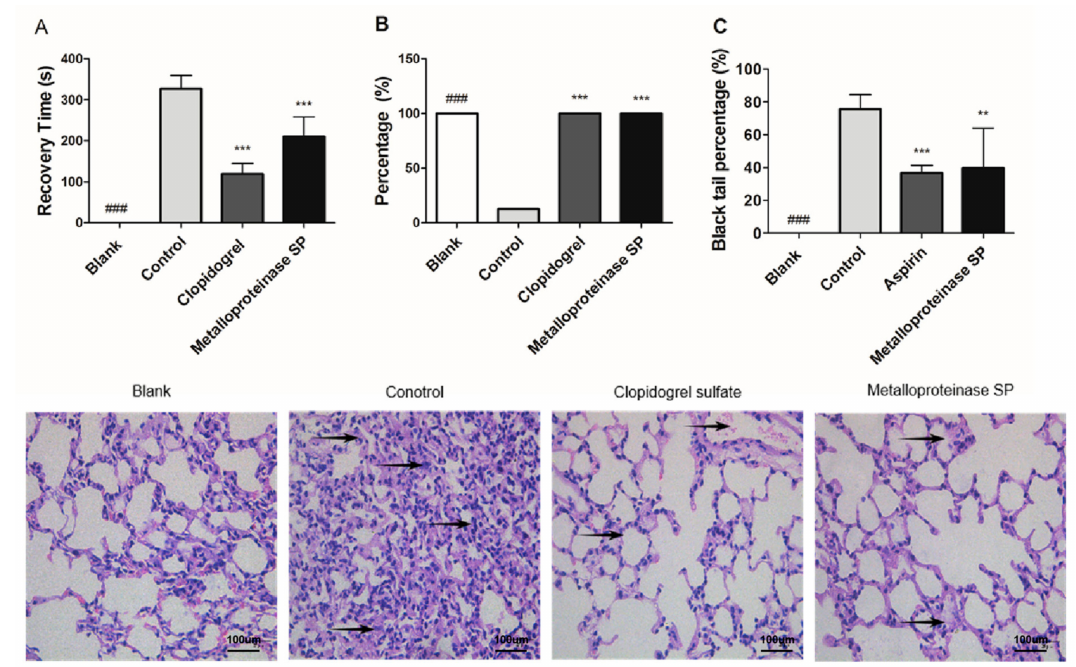
Figure 3. E ff ects of metalloproteinase SP on thrombosis. ( A ) Metalloproteinase SP inhibited the tail thrombus induced by the Carrageenan. ( B , C ) Metalloproteinase SP inhibited ADP-induced acute pulmonary thrombosis in mice. ADP (250 mg / kg) was intravenously injected to induce acute pulmonary thrombosis. The time that the mice righting reflex recovery was recorded as the recovery time. The hematoxylin and eosin stained section of the lung tissue shows the one for the control mouse to be dominated by thrombi. E ff ect of metalloproteinase SP on the ADP-induced formation of acute pulmonary thromboembolism in mice. Compared with the control group, the thrombus of the metalloproteinase SP and the clopidogrel group exhibited significant di ff erence. All data were expressed as mean ± SD, compared with the control group, ** p < 0.01, *** p < 0.001 and compared with the blank group ### p <